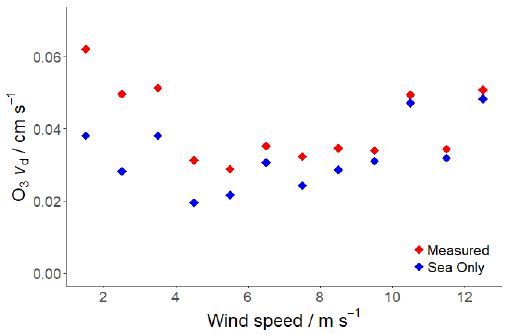
Figure 10. Median deposition velocities in 1ms − 1 wind speed bins for combined land and sea surfaces as measured (red) and for sea only (blue). Sea only values were calculated by subtracting the land contribution, estimated from the land cover and land deposition de- termined by least-squares regression. Periods with wind speeds be- low 3ms − 1 were not included in the final results.